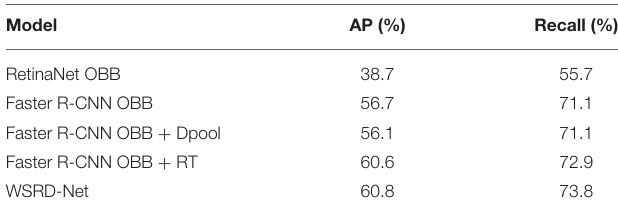
TABLE 1 | Detection results of WSRD-Net compared with the state-of-the-art oriented object detection